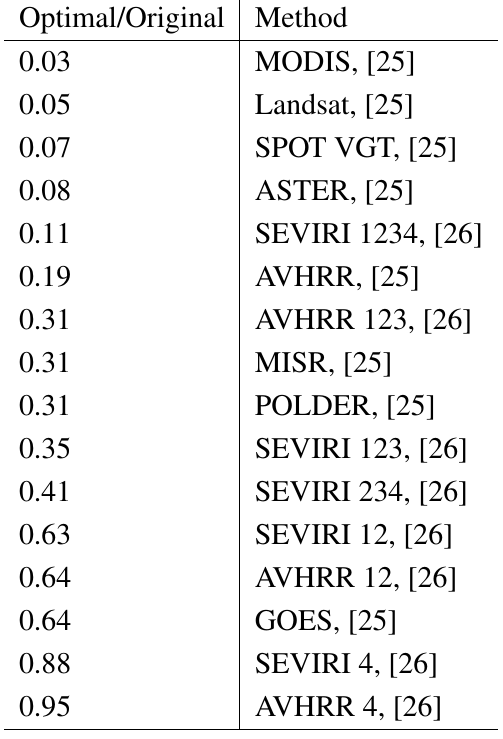
Table 3. The ratio of the mean difference of albedo estimates derived by (1) using broadband conversion; and, (2) direct integration of the BRF spectrum. In the nominator, the broadband conversion has been derived using optimised parameter values and, in the denominator, by using original parameter